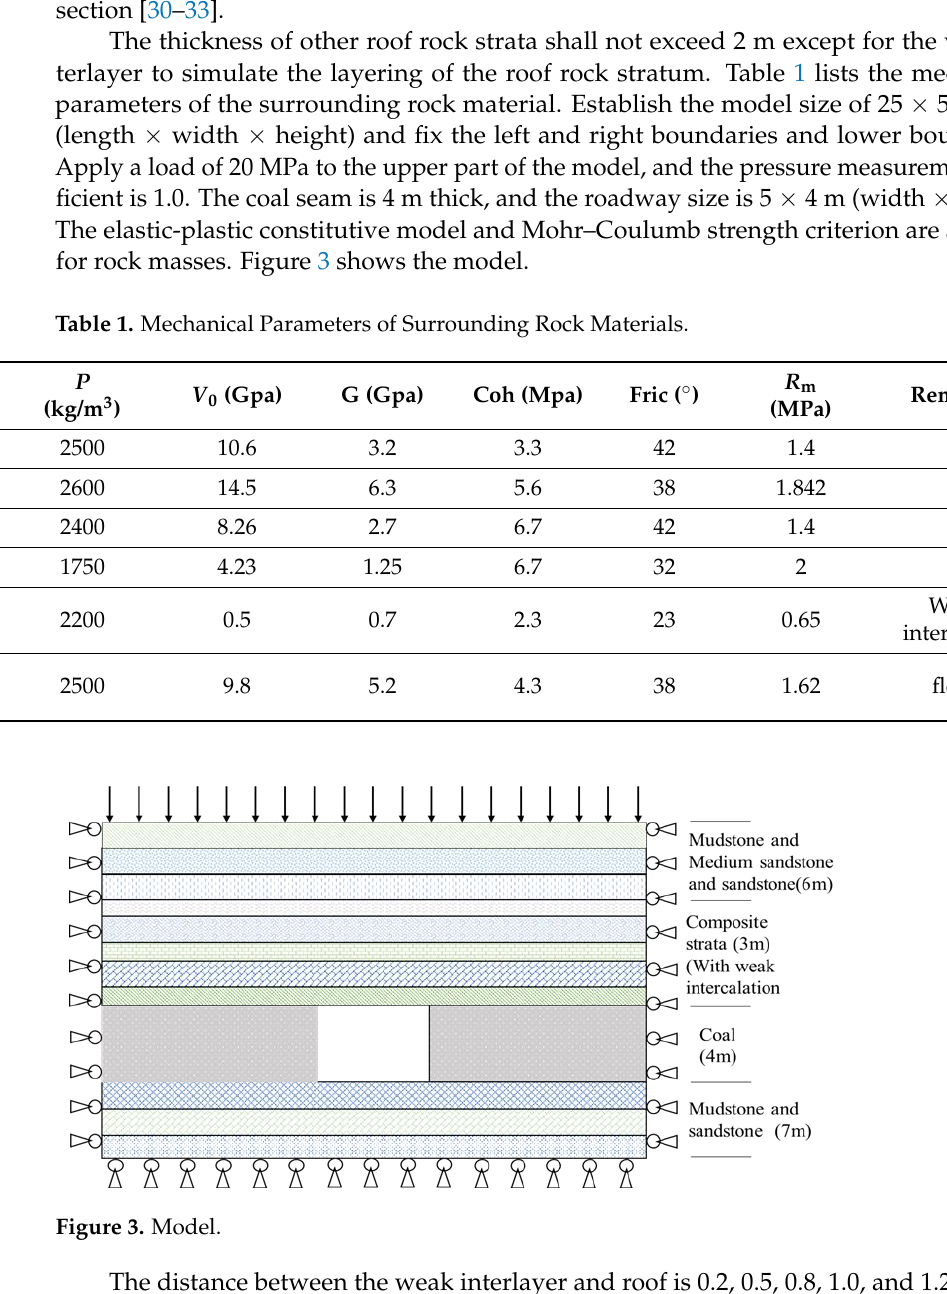
Table 1. Mechanical Parameters of Surrounding Rock